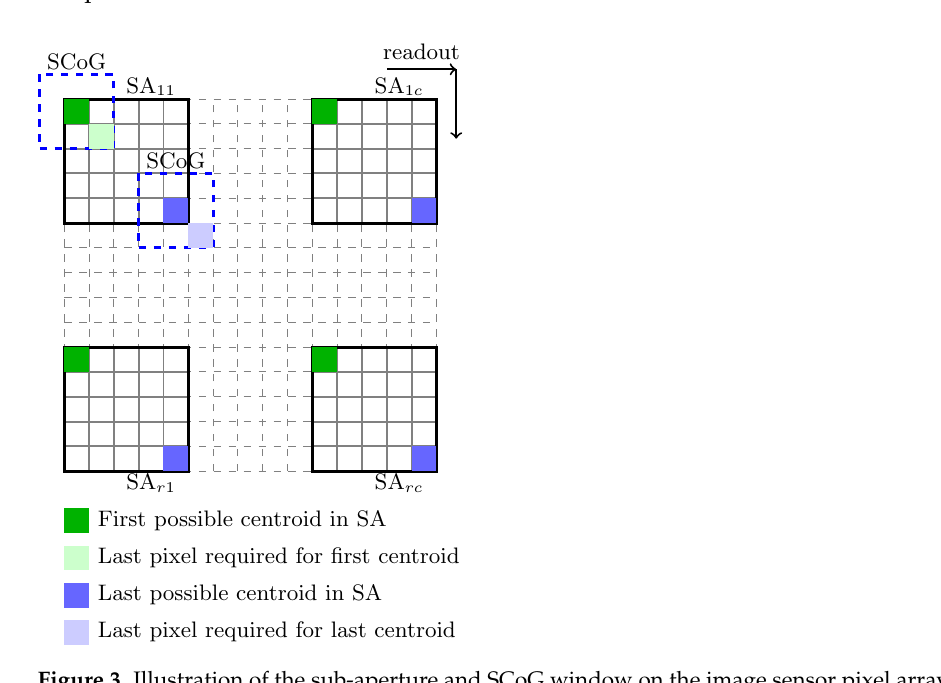
Figure 3. Illustration of the sub-aperture and SCoG window on the image sensor pixel array. A high level logic diagram for calculating the stream centroid according to Section